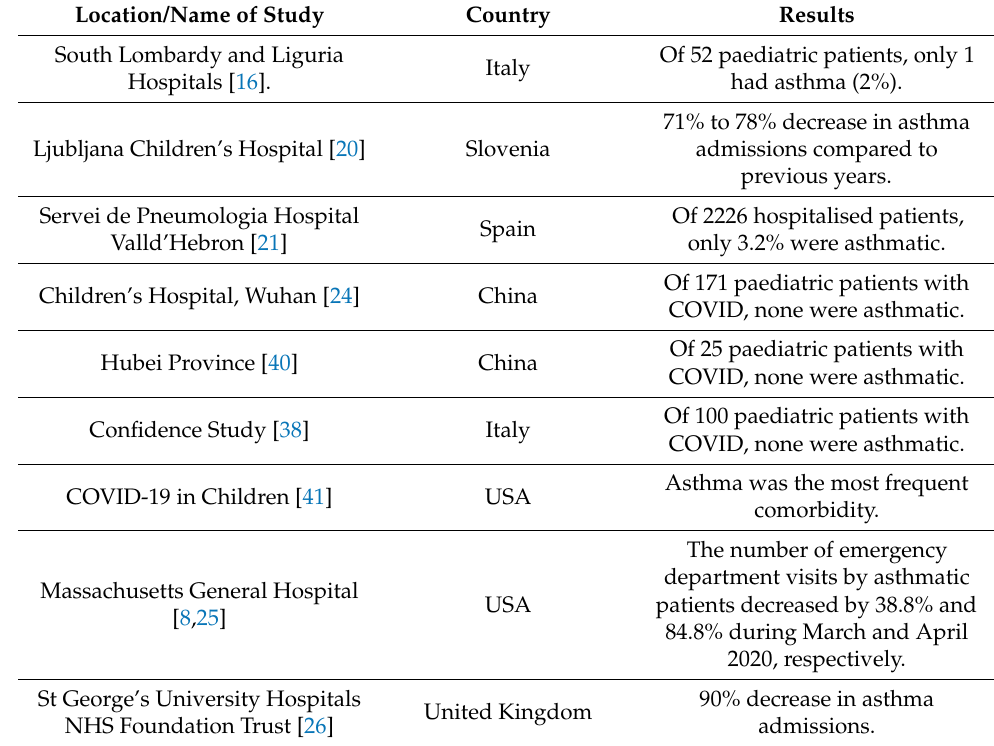
Table 2. Prevalence of paediatric asthma in COVID-19